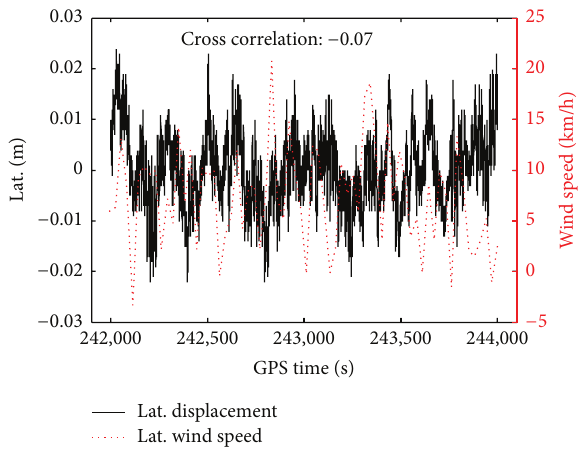
Figure 6: Lateral displacement and wind